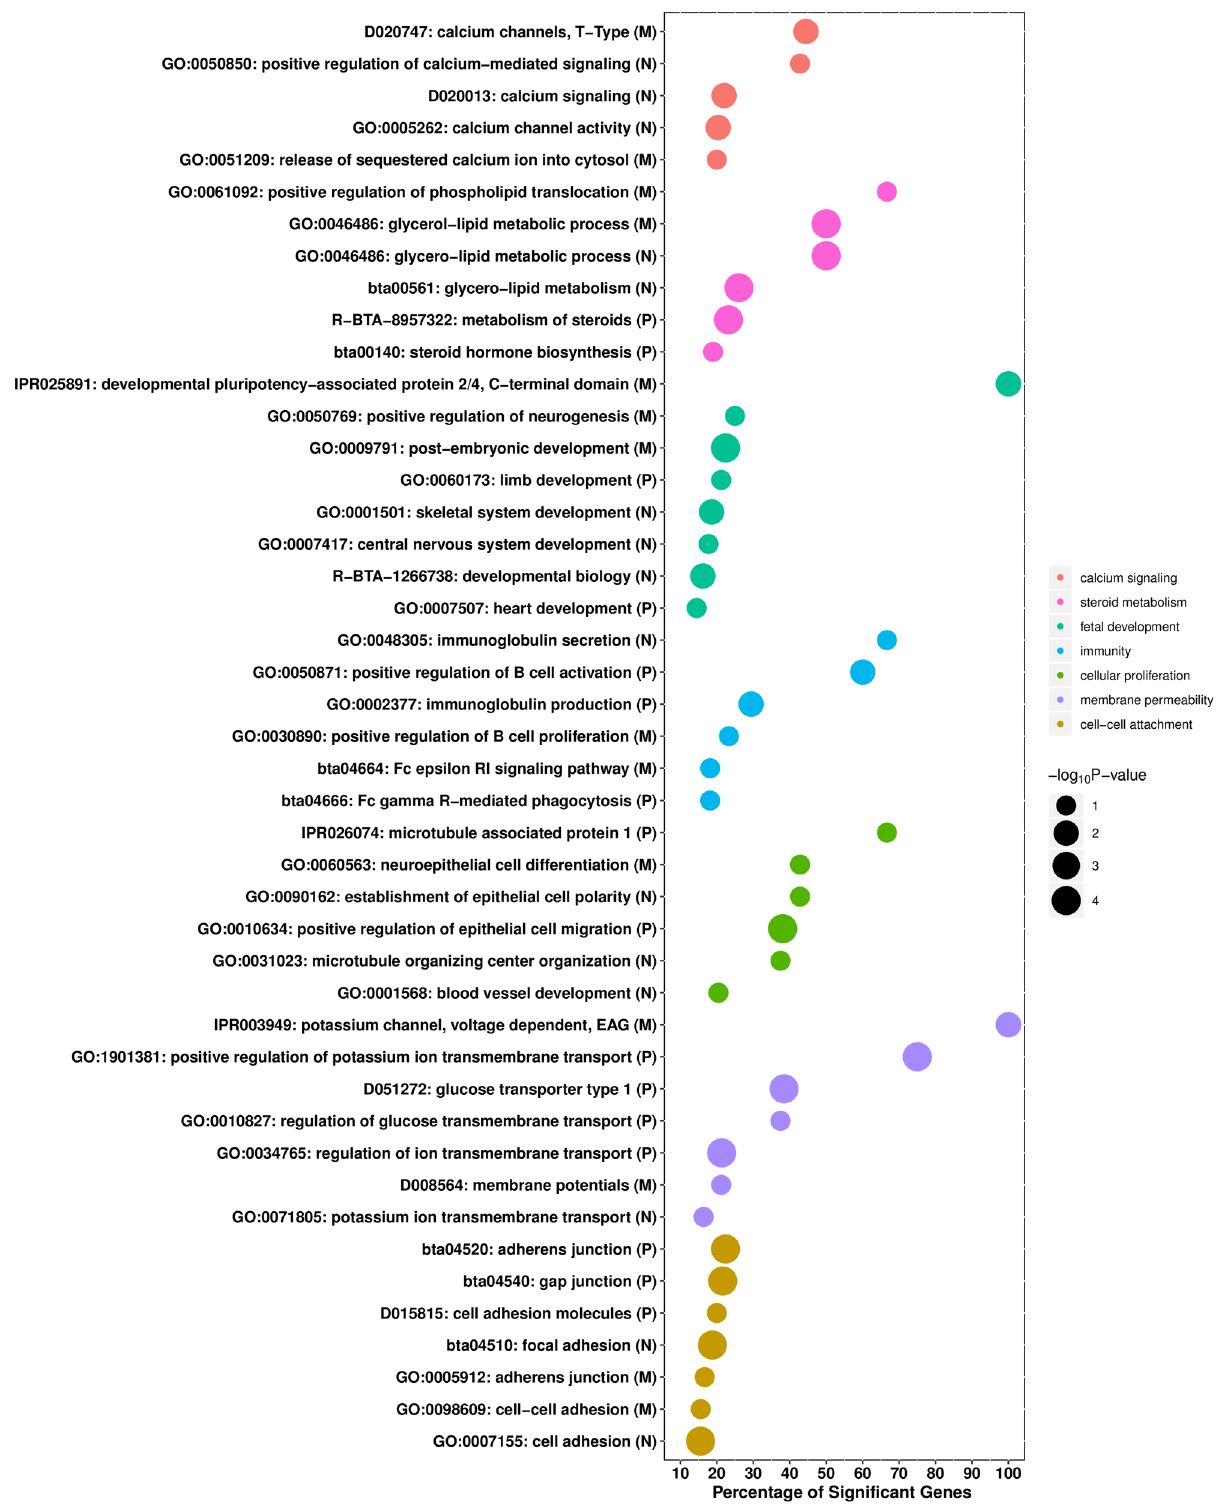
Figure 2. Functional terms and pathways significantly enriched with genes associated with pregnancy loss. Several annotation databases were analyzed, including GO, Medical Subject Headings, InterPro, Reactome and MSigDB. The y-axis displays the names of gene-sets associated with pregnancy loss, and letters within parenthesis represent the three parities (N: Nulliparous; P: Primiparous and M: Multiparous). The size of the dots represents the significance of enrichment (− log 10 P- Value, Fisher’s exact test) and x-axis represents the percentage of significant genes in each functional